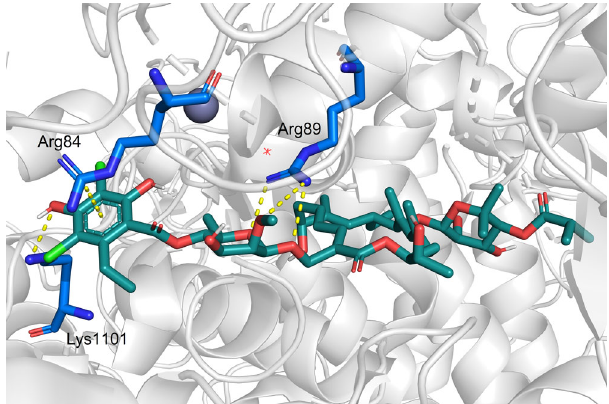
Fig. 3 Cryo-EM structure of fi daxomicin binding to M. tuberculosis RNAP (PDB ID: 6FBV) 18 . Fidaxomicin (cyan), protein (gray), and amino acid residues (blue). Detailed view on the interactions of the rhamnose- resorcylate part to